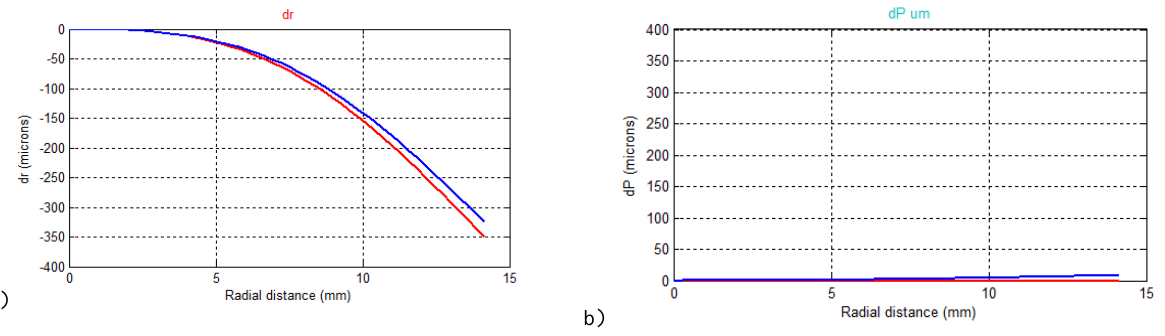
Figure 8. (a) Radial and (b) decentering distortion curves: the curves in red are related to the camera calibration in air, the curves in blue to the camera calibration underwater.